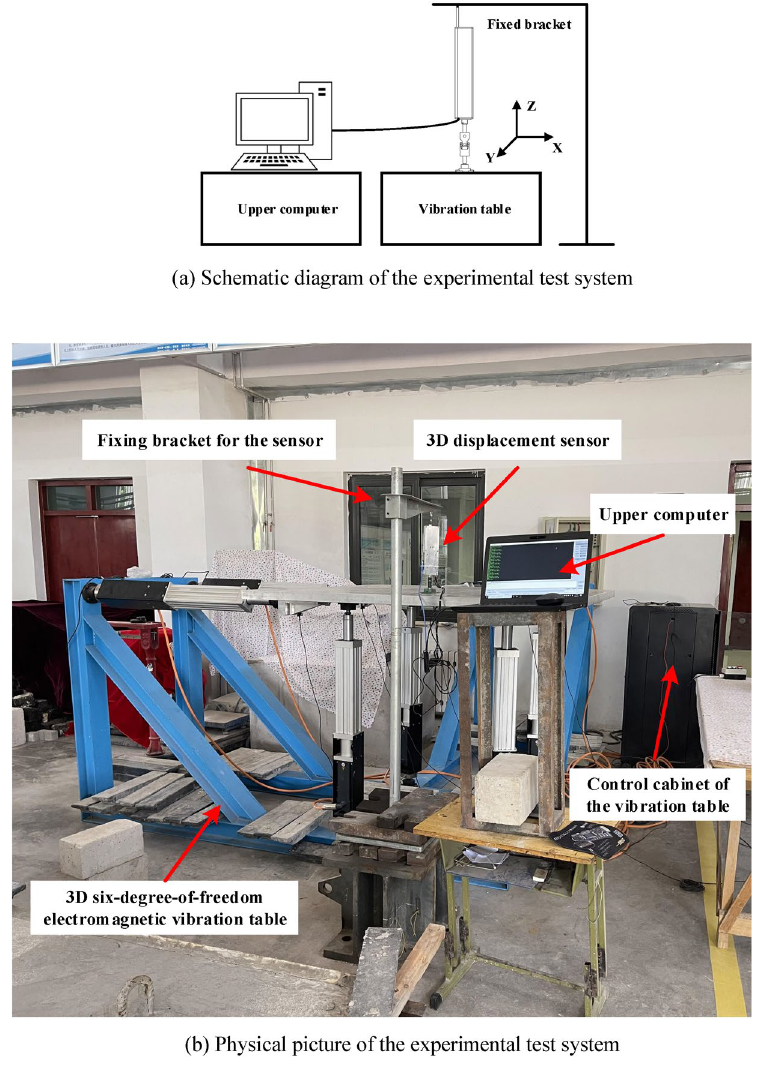
Figure 22. Dynamic 3D space displacement test system (( a , b )were generated by Microsoft Visio Professional 2016 (https:// www. micro soft. com/ zh- CN/ downl oad/ detai ls. aspx? id=